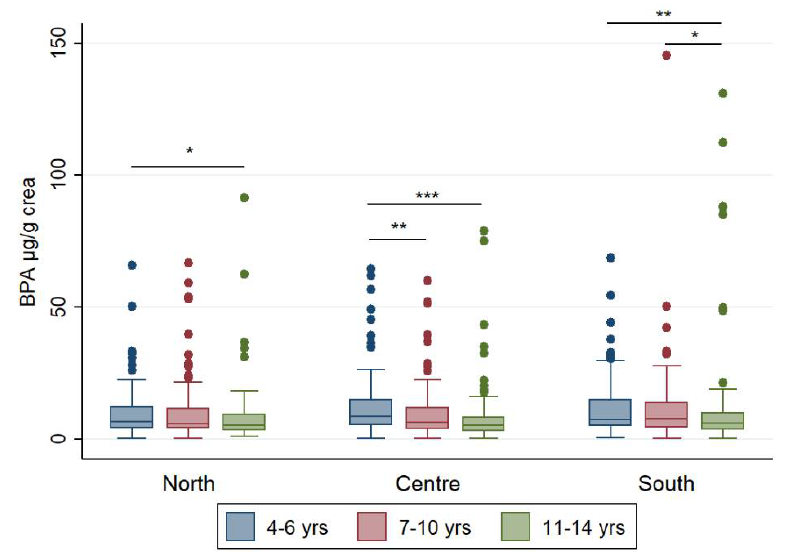
Figure 2. Box plots for BPA levels in urine samples of Italian children stratified by macro-area and age classes and normalized to urine creatinine content (µg/g). Outliers above 150 µg/g crea were excluded from the graph to improve box plot visibility. Asterisks indicate the level of significance: * p < 0.05, ** p < 0.01, *** p < 0.001.